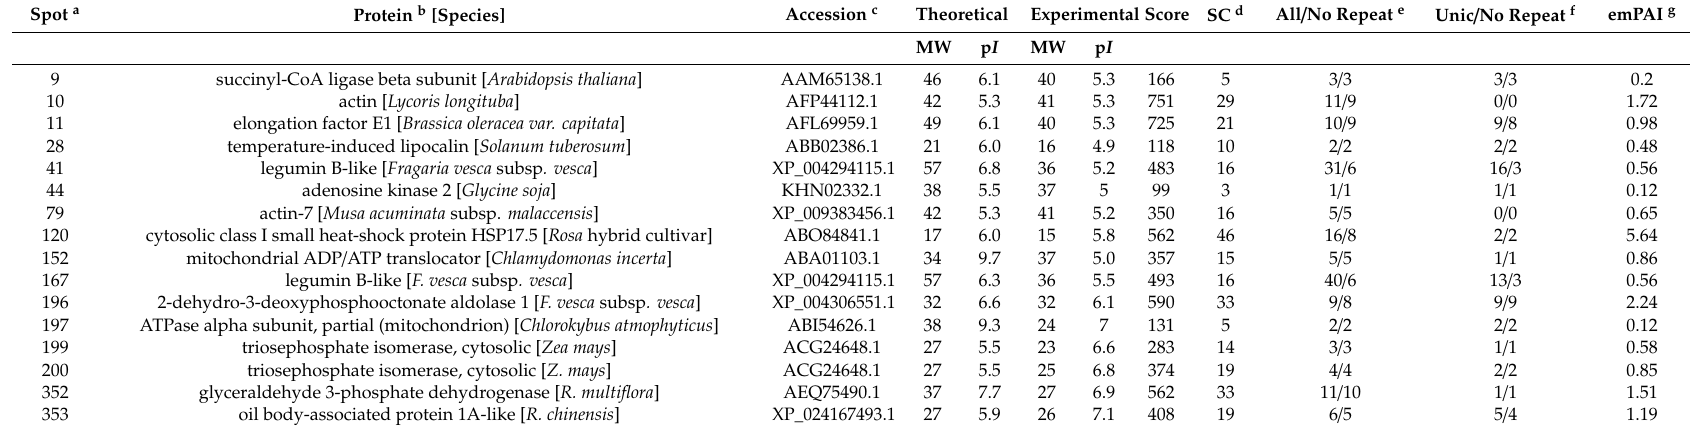
Table 1. Identification of di ff erentially abundant proteins of Rosa canina L. seeds during primary dormancy release by warm (25 ◦ C) and cold (3 ◦ C) stratification and secondary dormancy induction by warm treatment (20 ◦